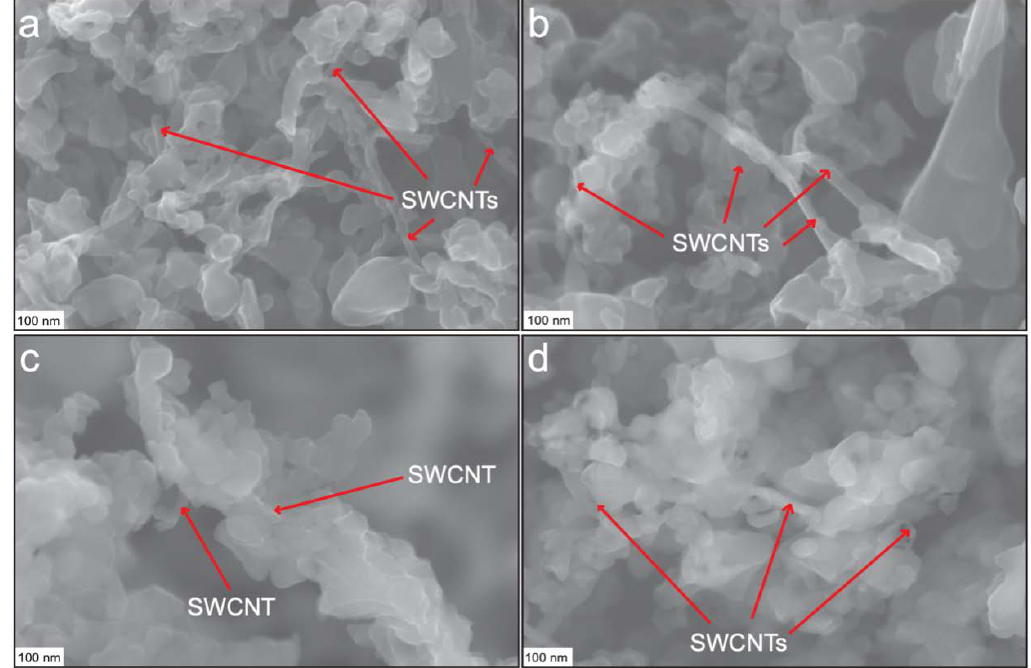
Figure 1. ( a )–( d ) FE-SEM images of copper(II)-oxide-single-walled carbon nanotube (CuO-SWCNT) nanocomposites. SWCNTs (designated by red arrows in each image) are surrounded by